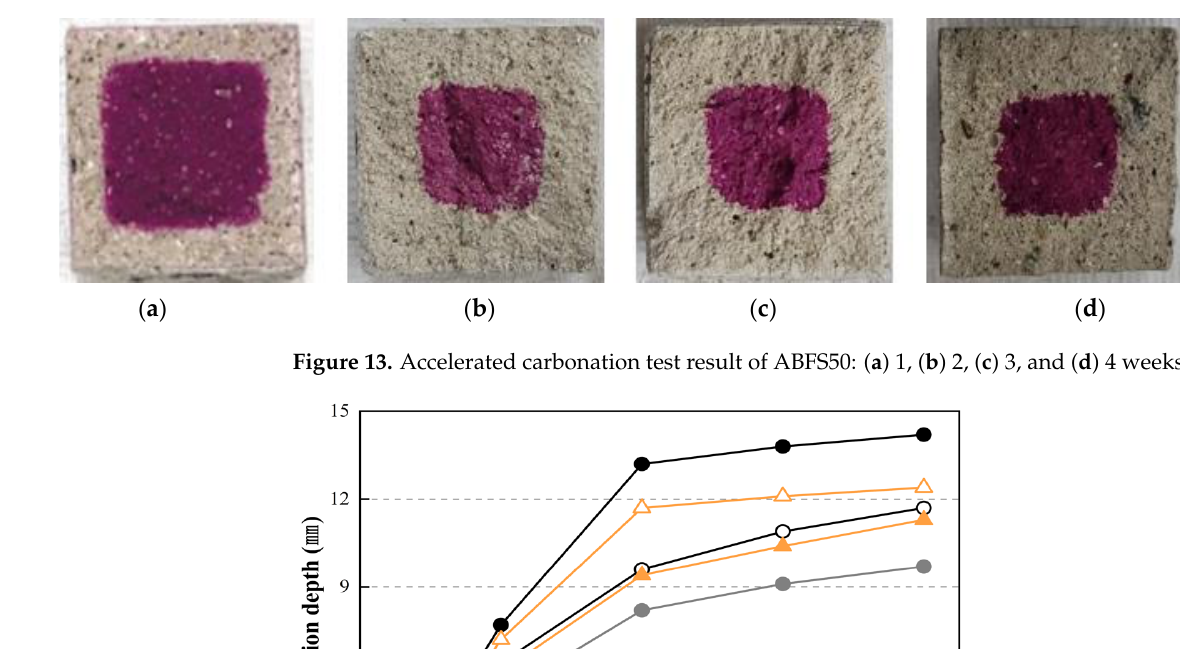
Figure 12. Accelerated carbonation test result of BFS50: ( a ) 1, ( b ) 2, ( c ) 3, and ( d ) 4 weeks.